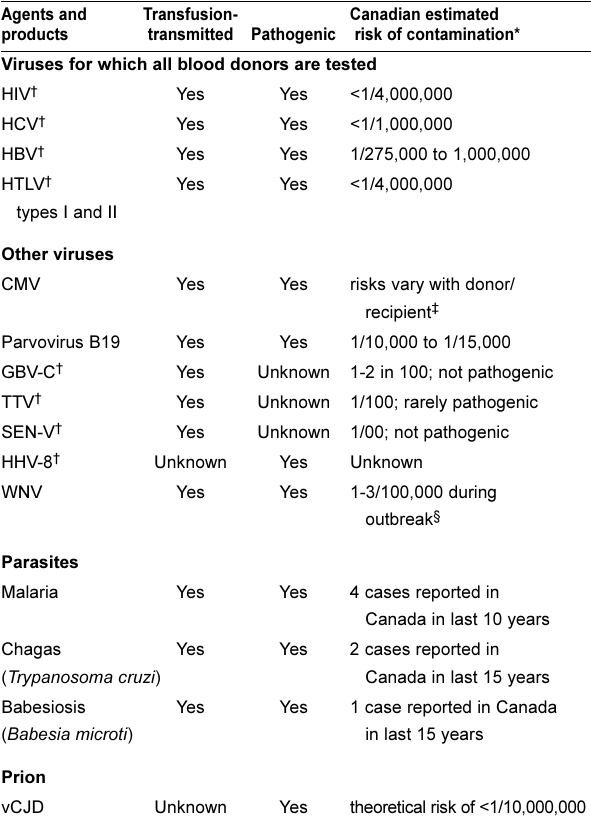
TABLE 6 Estimated risks of infectious agents in